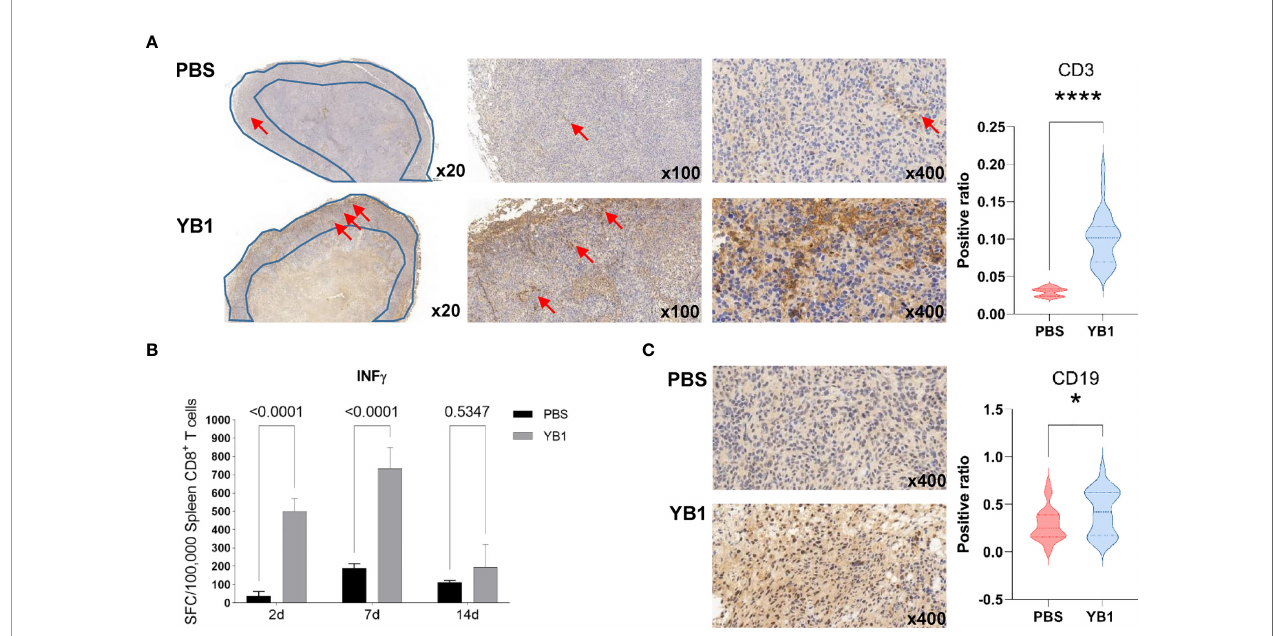
FIGURE 5 | Salmonella YB1 induced the adaptive immune responses in tumors. (A) Representative images of immunohistochemical stained tumor slices collected from mice injected with phosphate-buffered saline (PBS) or YB1 at 7 days post injection. The area of the blue polygon indicates the invasive margin of the tumor, the red arrow represents CD3 + T cells. An S/N ratio of CD3 + cells in the invasion margin of tumors. (B) CD8 + T cells from YB1 (gray) and PBS (black) treated mice spleen were stimulated by MB49 cells. The background value of IFN- g expression of CD8 + T cells has been removed. IFN- g ELISpot results of three replicates are expressed as mean SFC (IFN- g -speci fi c spot-forming cells)/100,000 CD8 + T cells. Error bars represent standard deviations. Statistical analysis was performed using the two-way ANOVA with S ̌ ida ́ k ’ s multiple comparisons test. (C) A ratio of CD19 + cells versus total cell numbers in the tumors. Statistical analysis in (A, C) was performed using the K – S test. * p < 0.05, **** p <